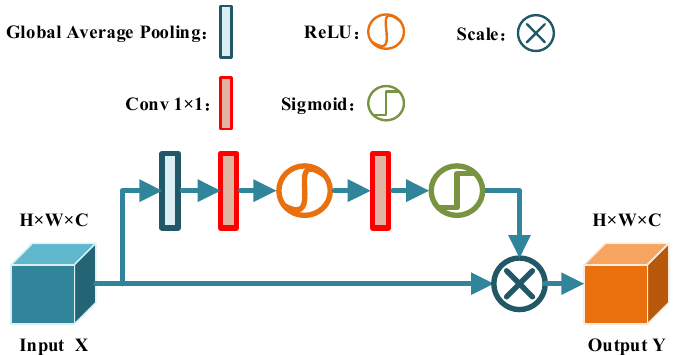
Figure 7. Channel attention module (CAM). In the CAM, firstly conduct Global Average Pooling (GAP) operation on input feature map X to obtain the Global information feature value of each channel feature map, and then conduct 1 × 1 convolution. Finally, the feature is transformed by ReLU activation, 1 × 1 convolution and Sigmoid operation to generate attention weight. The weight is multiplied by the input feature map X to obtain the output feature map Y, so as to achieve feature recalibration along the channel direction.